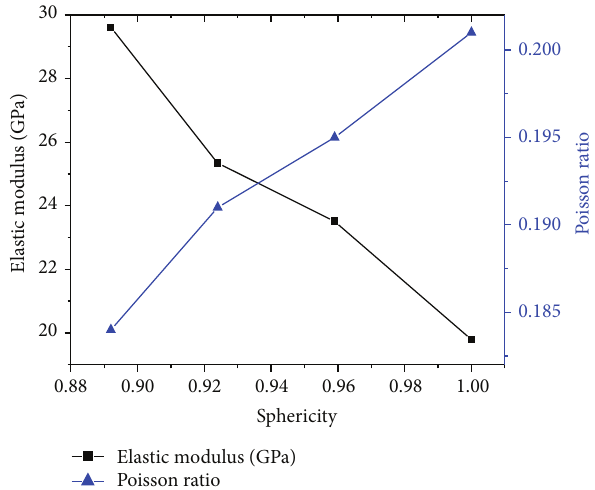
Figure 14: The variation of modulus of elasticity and Poisson ratio with